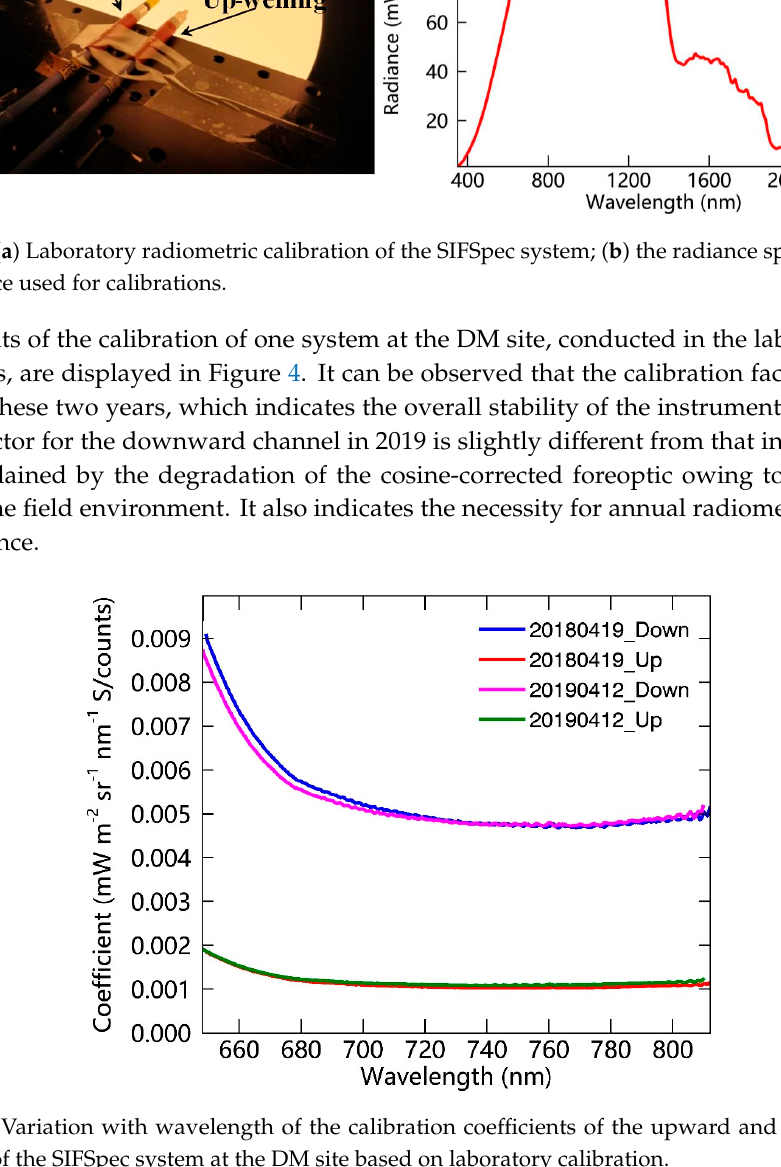
Figure 4. Variation with wavelength of the calibration coefficients of the upward and downward channels of the SIFSpec system at the DM site based on laboratory calibration. channels of the SIFSpec system at the DM site based on laboratory